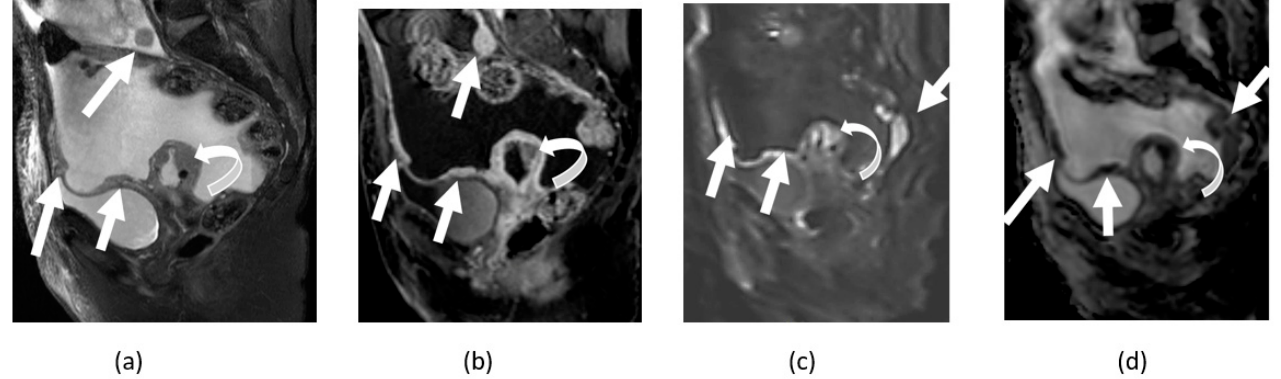
Figure 18. Sagittal T2-weighted ( a ) and T1-weighted FS contrast-enhanced ( b ) images of patient with metastatic endometrial cancer with malignant ascites showing peritoneal thickening and nodules showing diffusion restriction in a small endometrial mass from biopsy-proven endometrial cancer (curved arrows) and metastatic peritoneal nodules (arrows) on the sagittal DWI ( c ) and ADC maps ( d ).